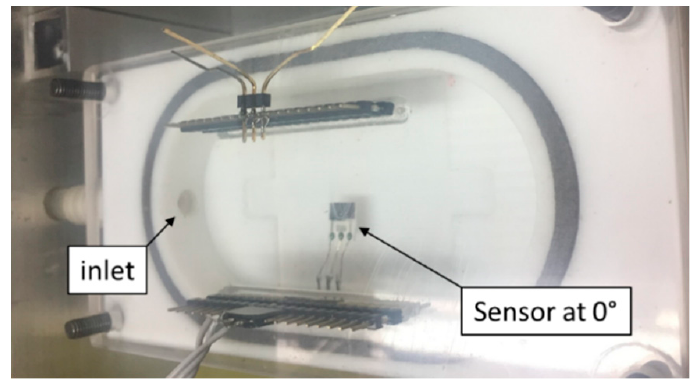
Figure 3. Sensor position in the gas chamber at angle 0°.